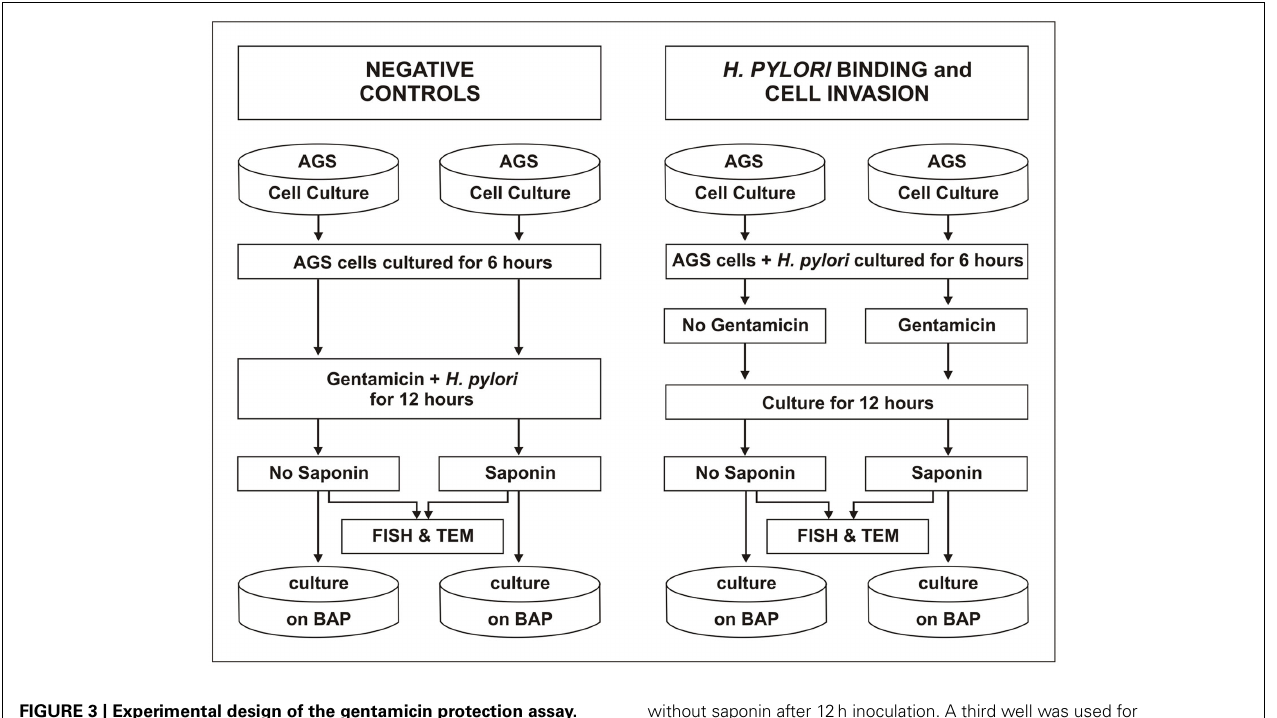
without saponin after 12h inoculation. A third well was used for measurement of H. pylori bound to cell membranes in the conditions without gentamicin and saponin.The last well was designed for measurement of H. pylori invasion into the cell with gentamicin and saponin added.The chamber slides prepared for morphologic observation were exactly the same as above.